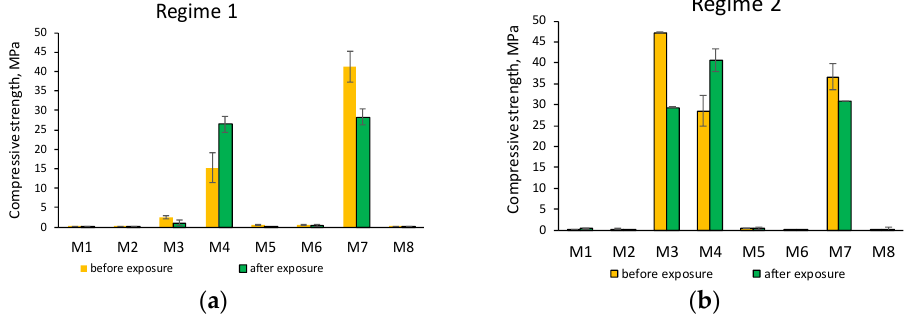
Figure 2. Compressive strength of AAC, before and after 24-h exposure in water cured in different regimes: ( a ) Regime 1; and ( b ) Regime 2.